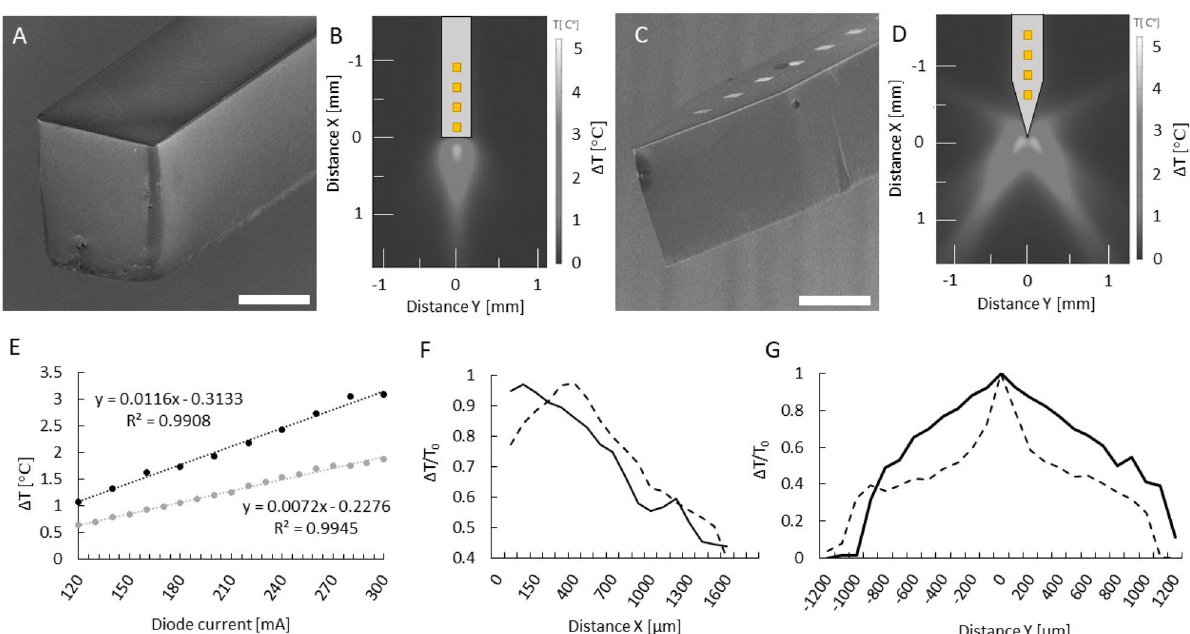
Figure 2. ( A , C ) Scanning electron microscopy view of different optrode tip versions. ( B , D ) Heat distribution based on the simulation of Boros et al. 24 . The grayscale colormap shows temperature differences in the °C range. ( E ) Representative calibration curve of a sharp (black) and a blunt (grey) tip optrode. ( F ) Axial decay of heat for sharp (normal line) and blunt (dashed line) tip optrodes. ( G ) Distribution of heat from along the axis Y perpendicular to the shaft at x = 200 µm from the tip of sharp (normal line) and blunt (dashed line) device. Scale bars are 100 µm in both ( A , C